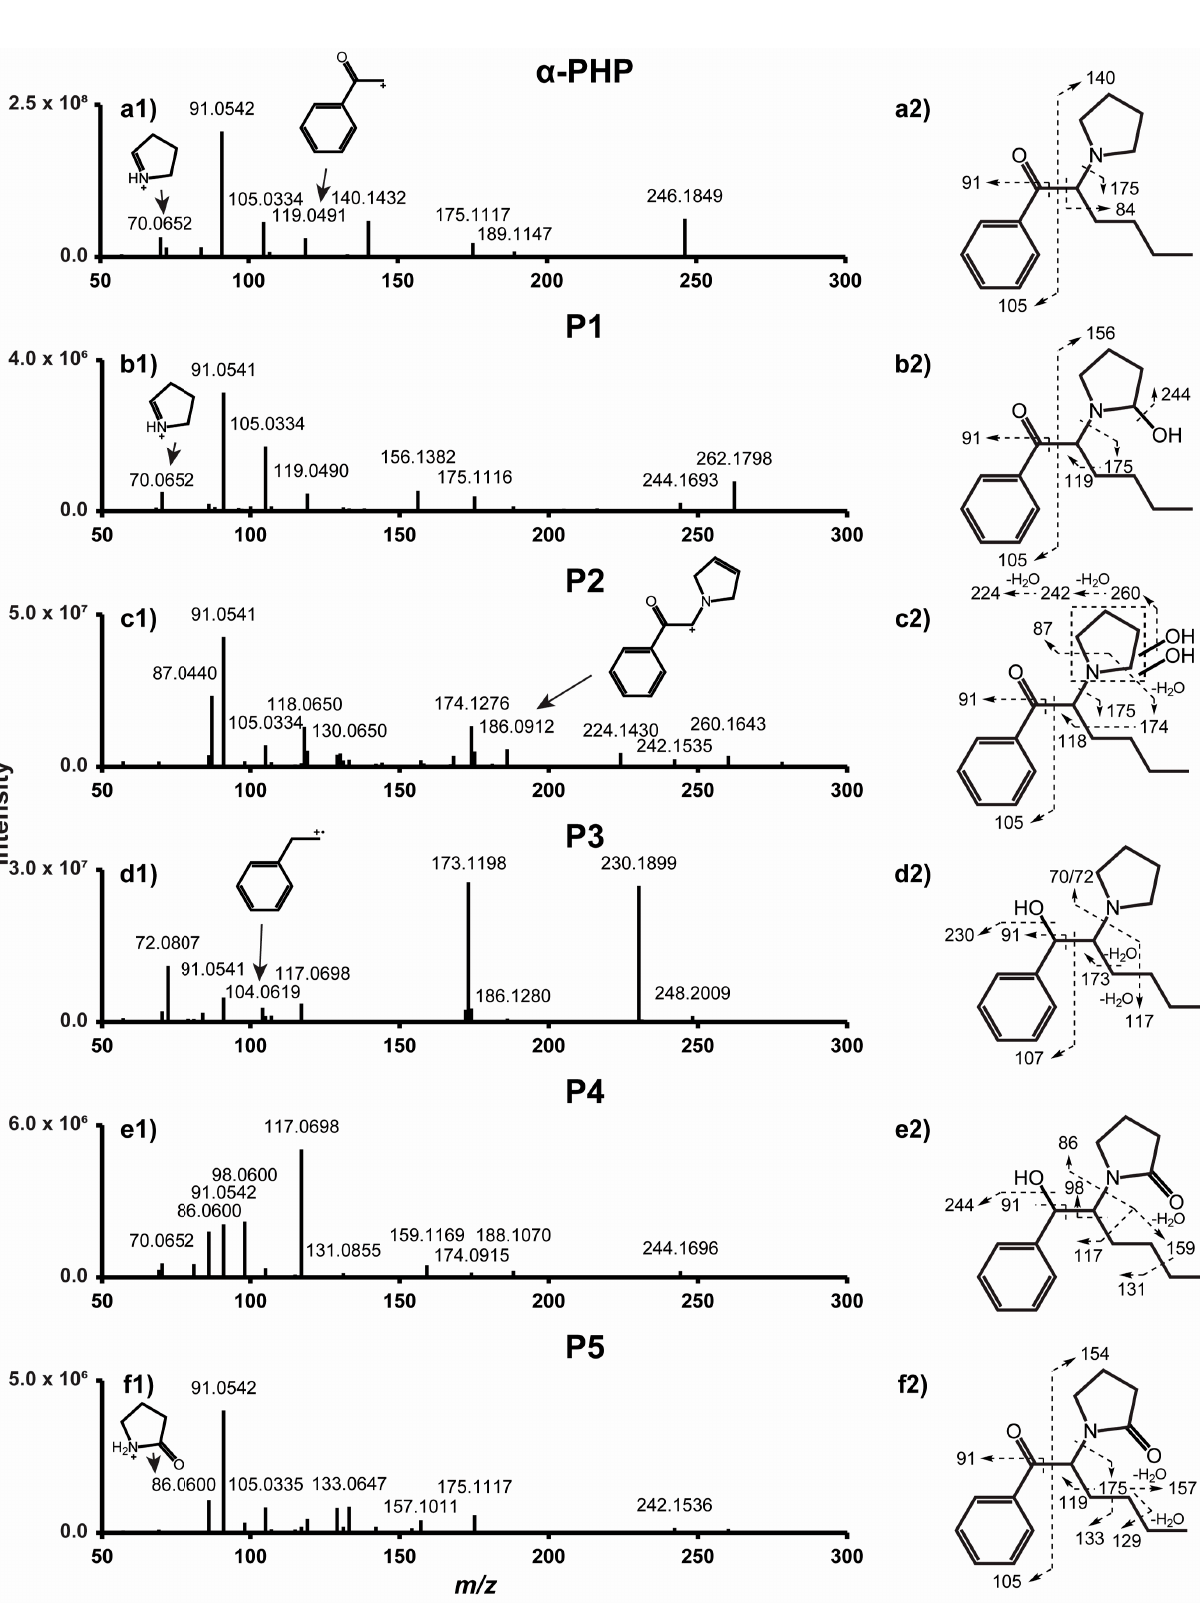
Figure 2. Product ion spectra of α -PHP ( a1 ) and metabolites P1 ( b1 ), P2 ( c1 ), P3 ( d1 ), P4 ( e1 ), and P5 ( f1 ), and their postulated fragmentation patterns ( a2 – f2 , respectively). Dashed arrow indicates fragmentation